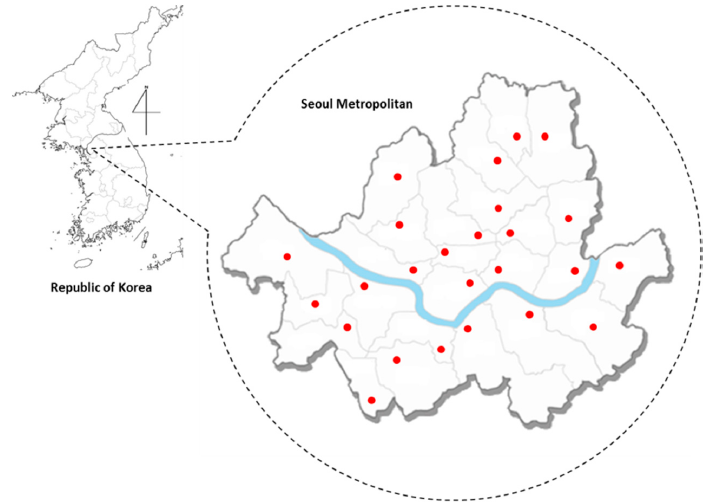
Figure 1. The distribution map of 25 monitoring stations for air pollutants ( • ), one in each administrative district of Seoul.